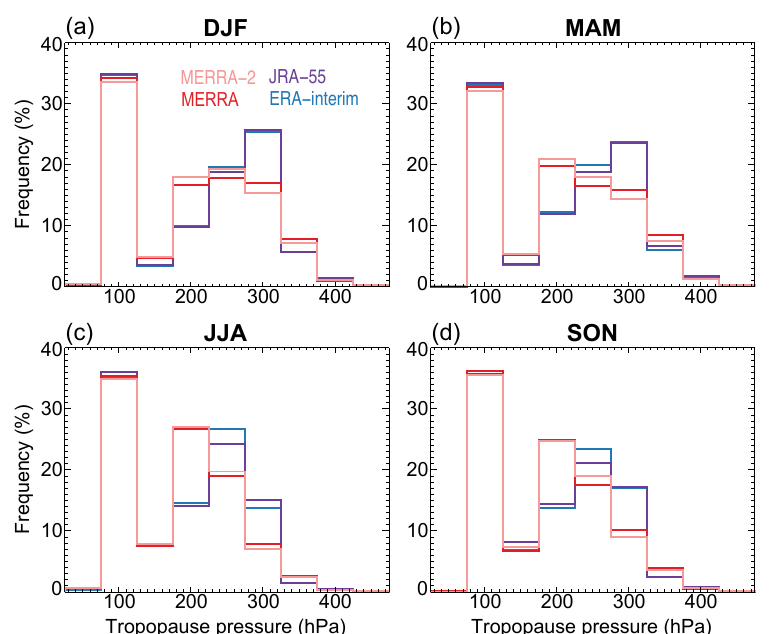
Figure 17. PDFs of global tropopause pressure (hPa) over the 15-year period (1996–2010), separated by season: (a) DJF, (b) MAM, (c) JJA, and (d) SON. JRA-55 is shown by the purple lines, ERA-Interim by the blue lines, MERRA-2 by the light red lines, and MERRA by the dark red